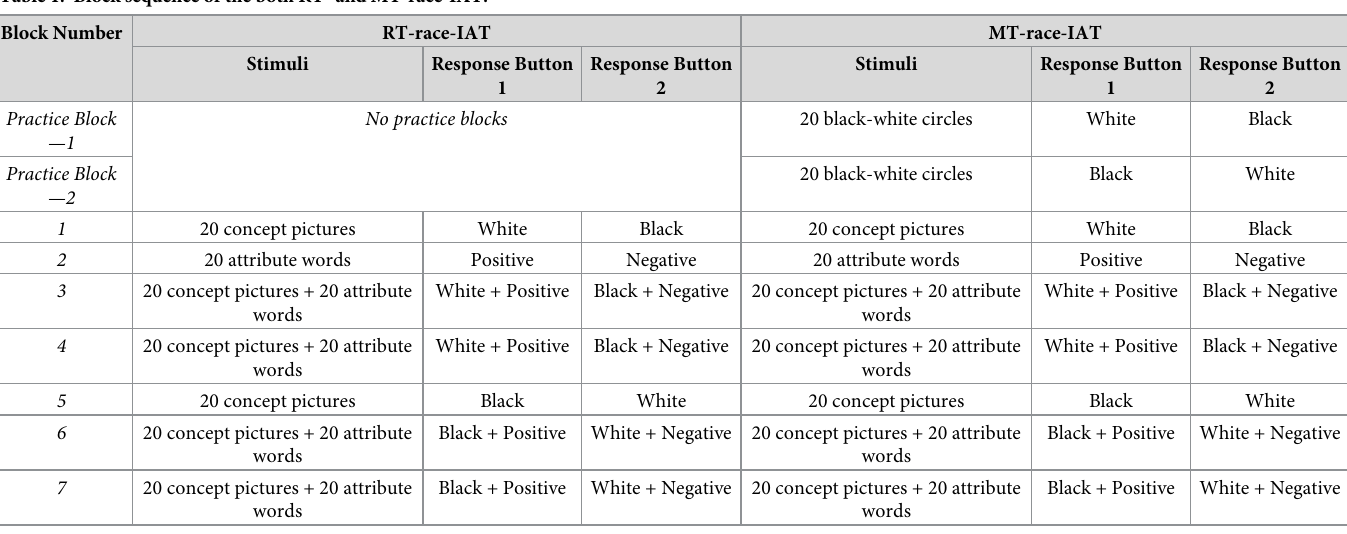
Table 1. Block sequence of the both RT- and